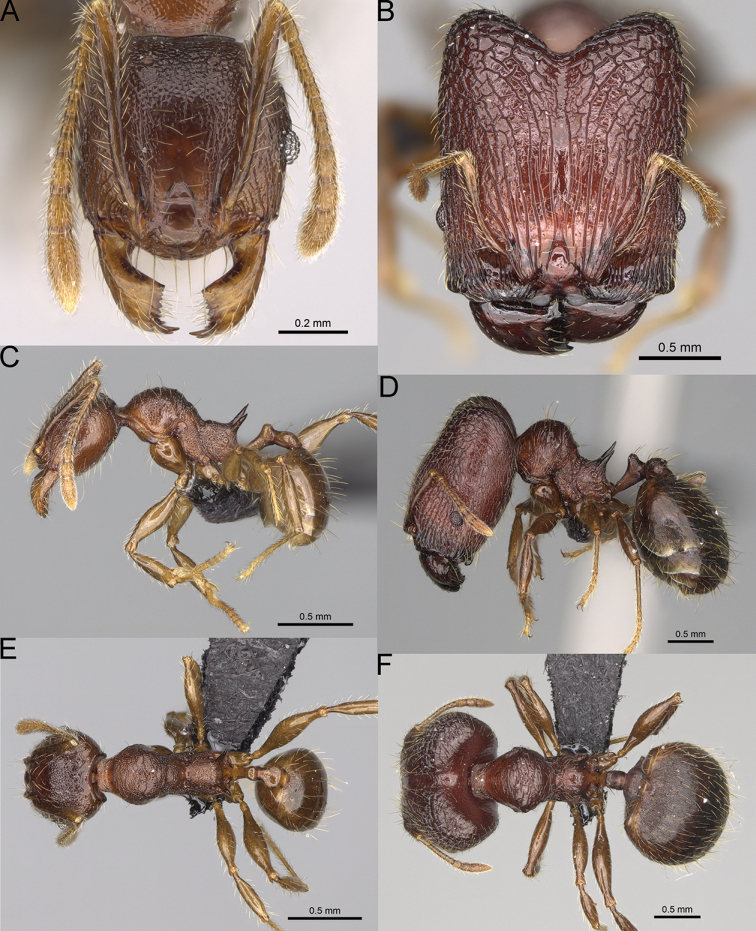
Pheidole
podargea sp. nov., full-face view (A), profile (C), and dorsal view (E) of paratype minor worker (CASENT0487567) and full-face view (B), profile (D), and dorsal view (F) of holotype major worker (CASENT0487570).